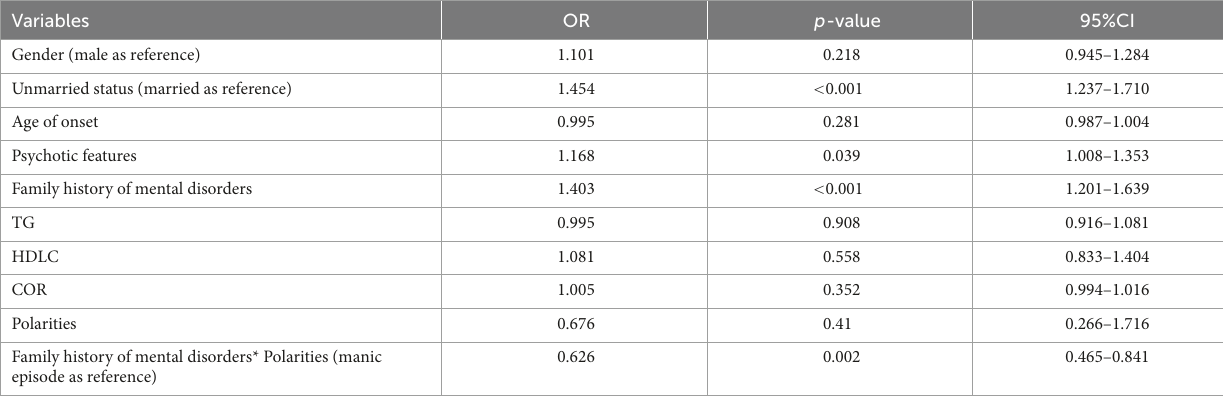
TABLE 3 Multivariate logistic regression analysis of LOS in the whole sample.